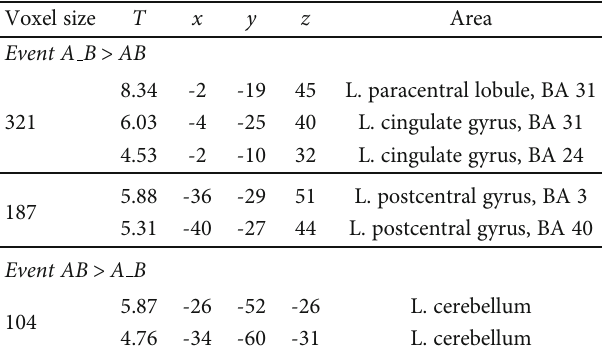
Table 5: Activities shown in the contrast of “ Event A B > AB ” and “ Event AB > A B ” .